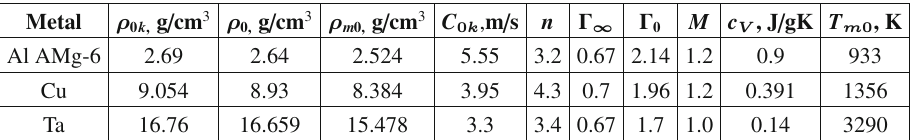
Table 1. Constant coe ffi cients of equations (5)–(6).